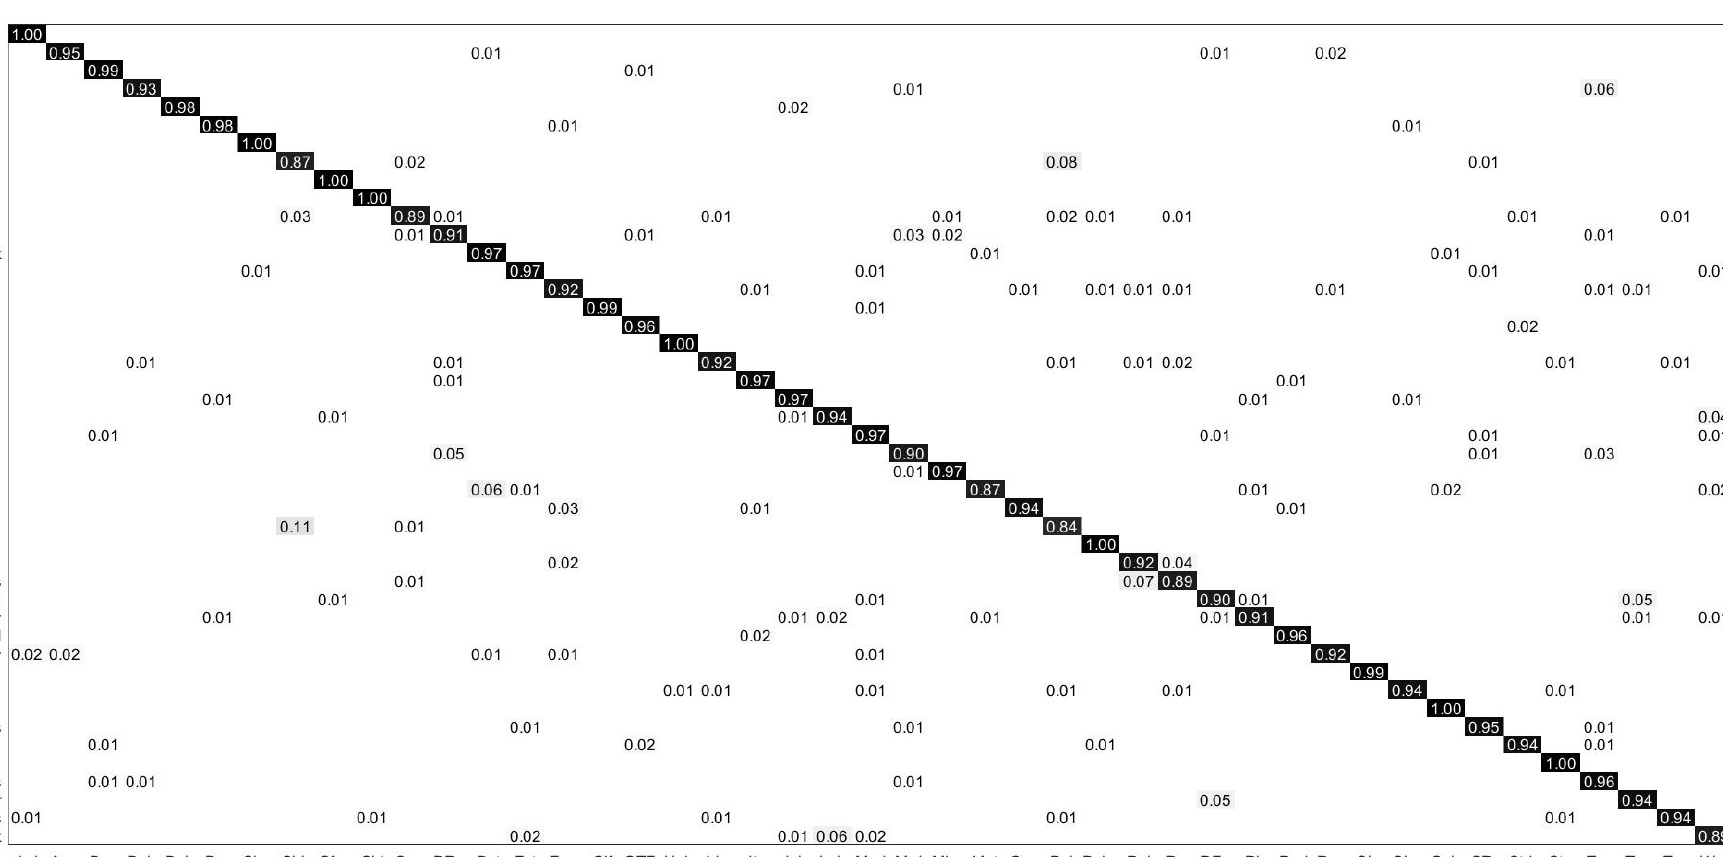
Figure 5. Confusion matrix of our proposed method on NWPU